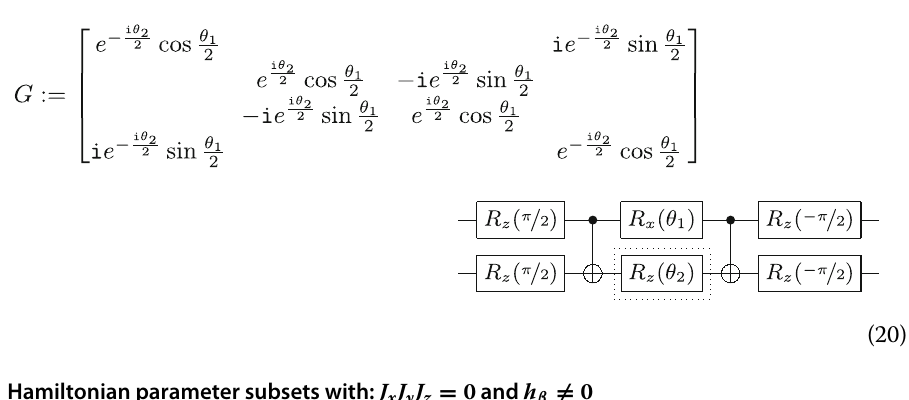
(cid:2) (cid:2) σ x σ x + h σ z or z i i i i + 1 i